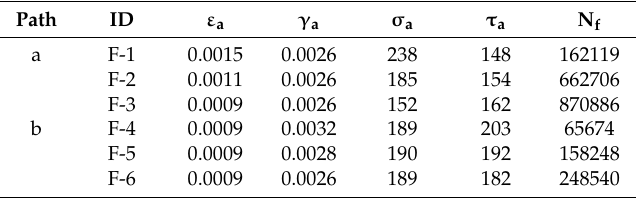
Table 5. Summary of the six experimental data used to fit the six parameters included in the SKS model.